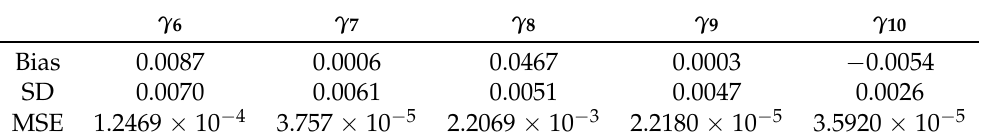
Table 8. Bias, SD and MSE evolutions with respect to the parameter γ variation for GNFPLSIM with the logistic link function and n = 500.